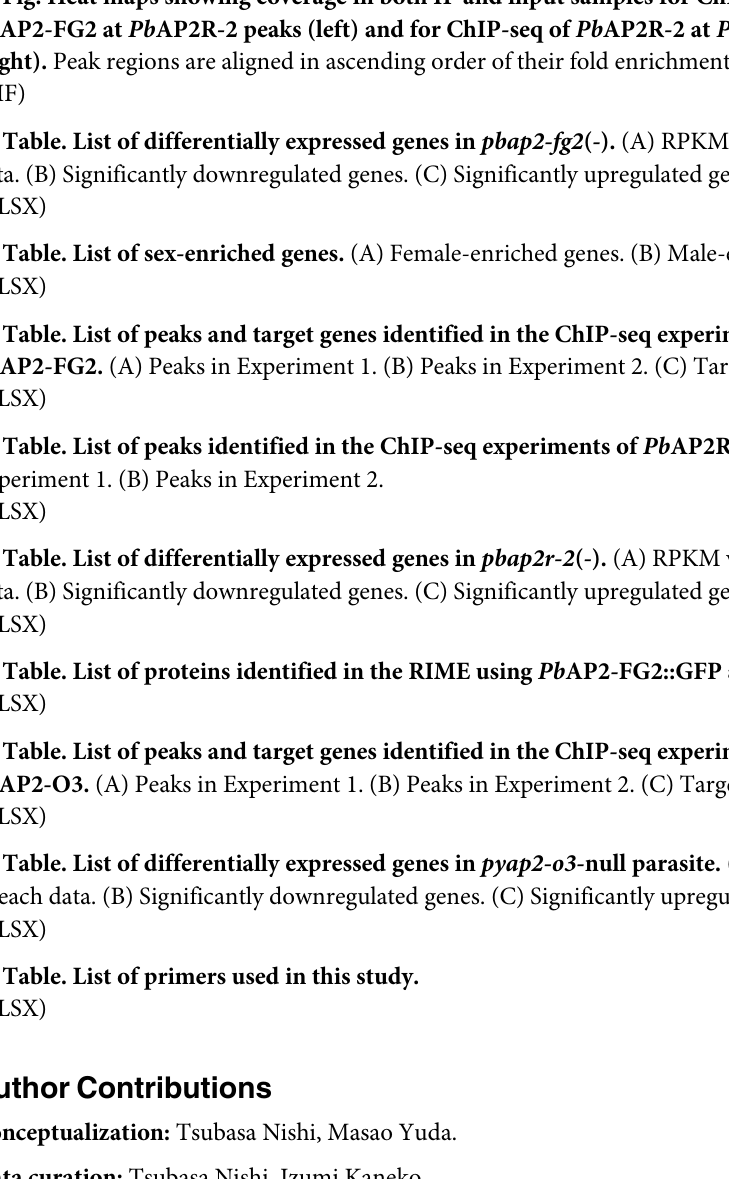
S8 Table. List of differentially expressed genes in pyap2-o3 -null parasite. (A) FPKM values in each data. (B) Significantly downregulated genes. (C) Significantly upregulated genes. S9 Table. List of primers used in this